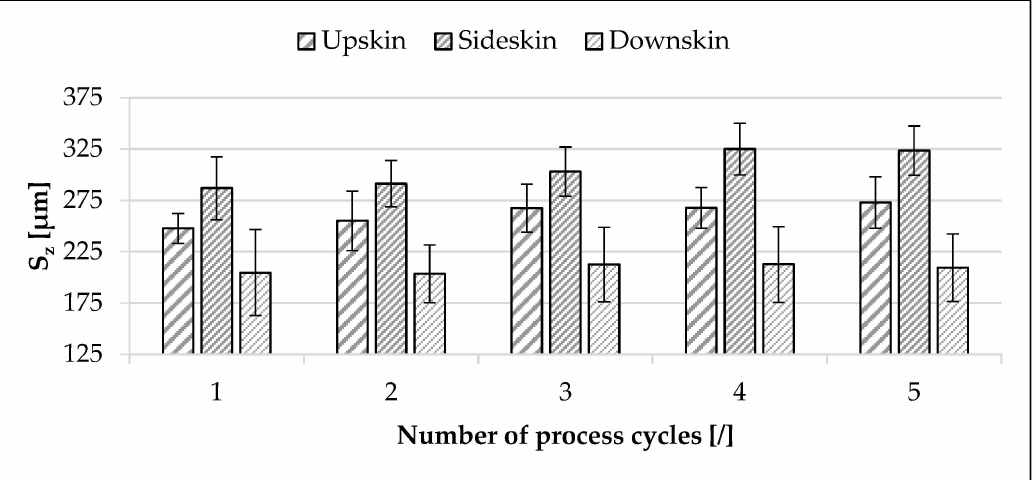
Figure 16. Influence of cyclic reuse on surface roughness (S z ) of the specimens manufactured from the used polyamide 12 sinter material. Five process cycles were considered. The upskin, sideskin, and downskin surfaces were analyzed. The refresh rate was 30